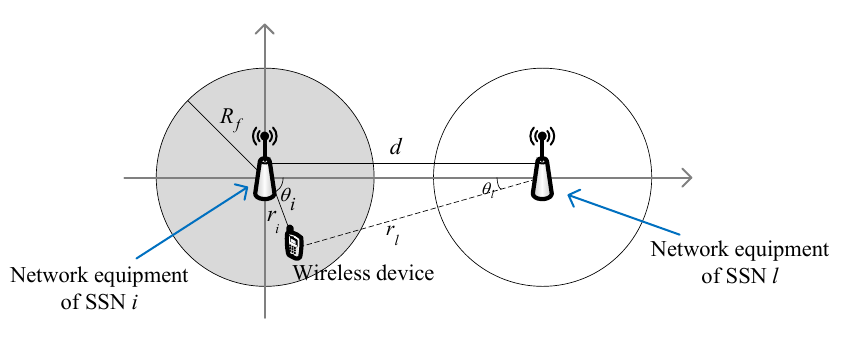
Figure A1. Two-SSN scenario with d > R